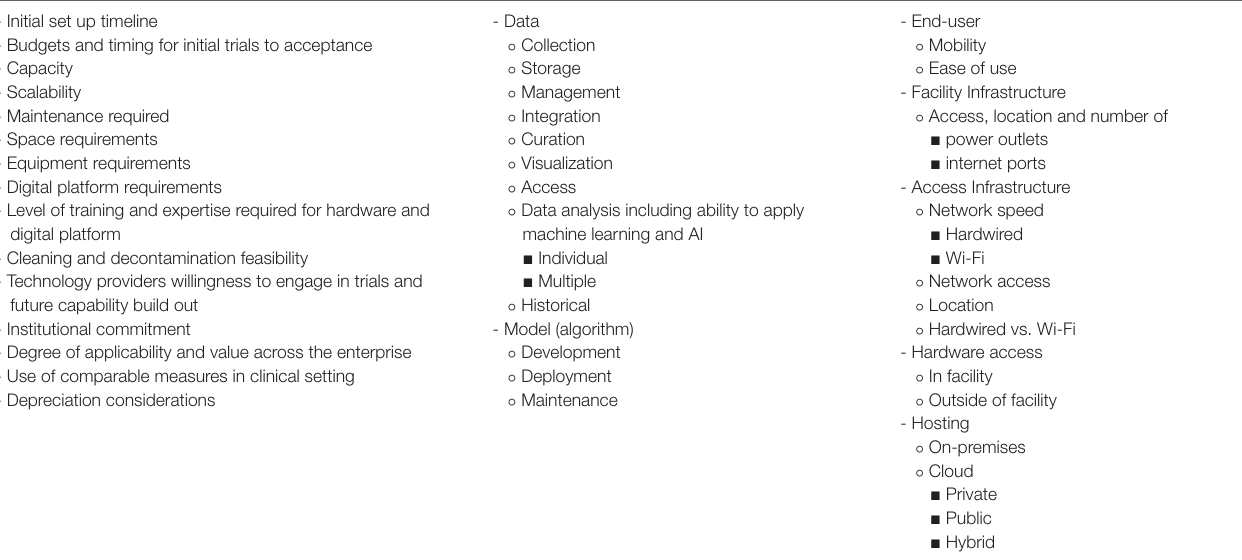
TABLE 3 | Suggested list of pragmatic information end users should consider prior to onboarding of scalable monitoring digital technologies. - Initial set up timeline - Budgets and timing for initial trials to